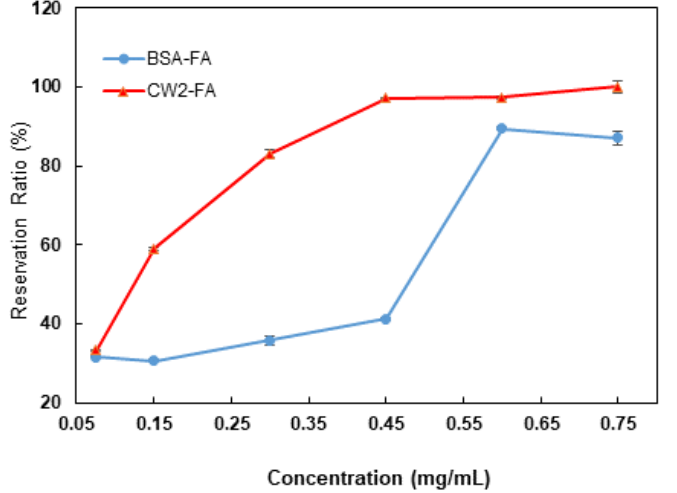
Figure 4. The reservation ratio of FA depending on the dose after exposure for 12 h under UVA. The concentration of FA was 5 µg/mL in the 2 groups. The blue line indicates the reservation ratio of BSA-FA groups after 12 h of UVA irradiation with a series of protein concentrations (0.075 mg/mL, 0.15 mg/mL, 0.3 mg/mL, 0.45 mg/mL, 0.6 mg/mL, and 0.75 mg/mL). The red line indicates the reservation ratio of CW2-FA groups, following the same treatment and concentrations as CW2. Points represent means ± SDs ( n = 3).